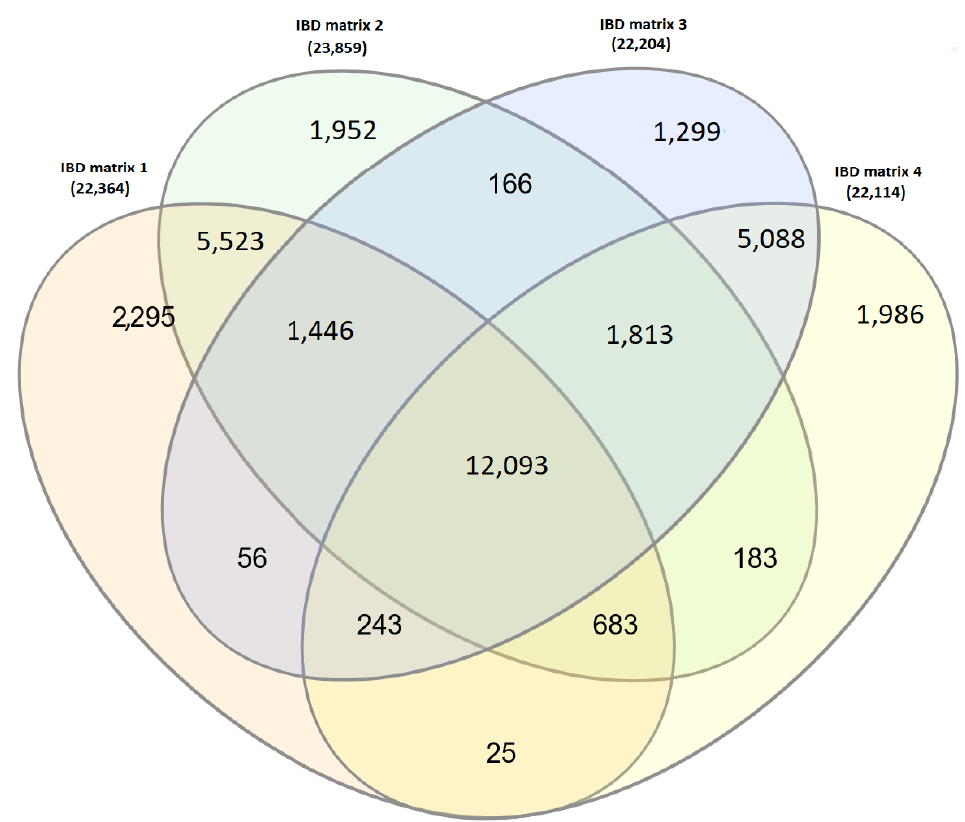
Figure 3. Venn diagram representing the relationships shared between the four IBD matrices. The relationships identified in a single IBD matrix are also represented.